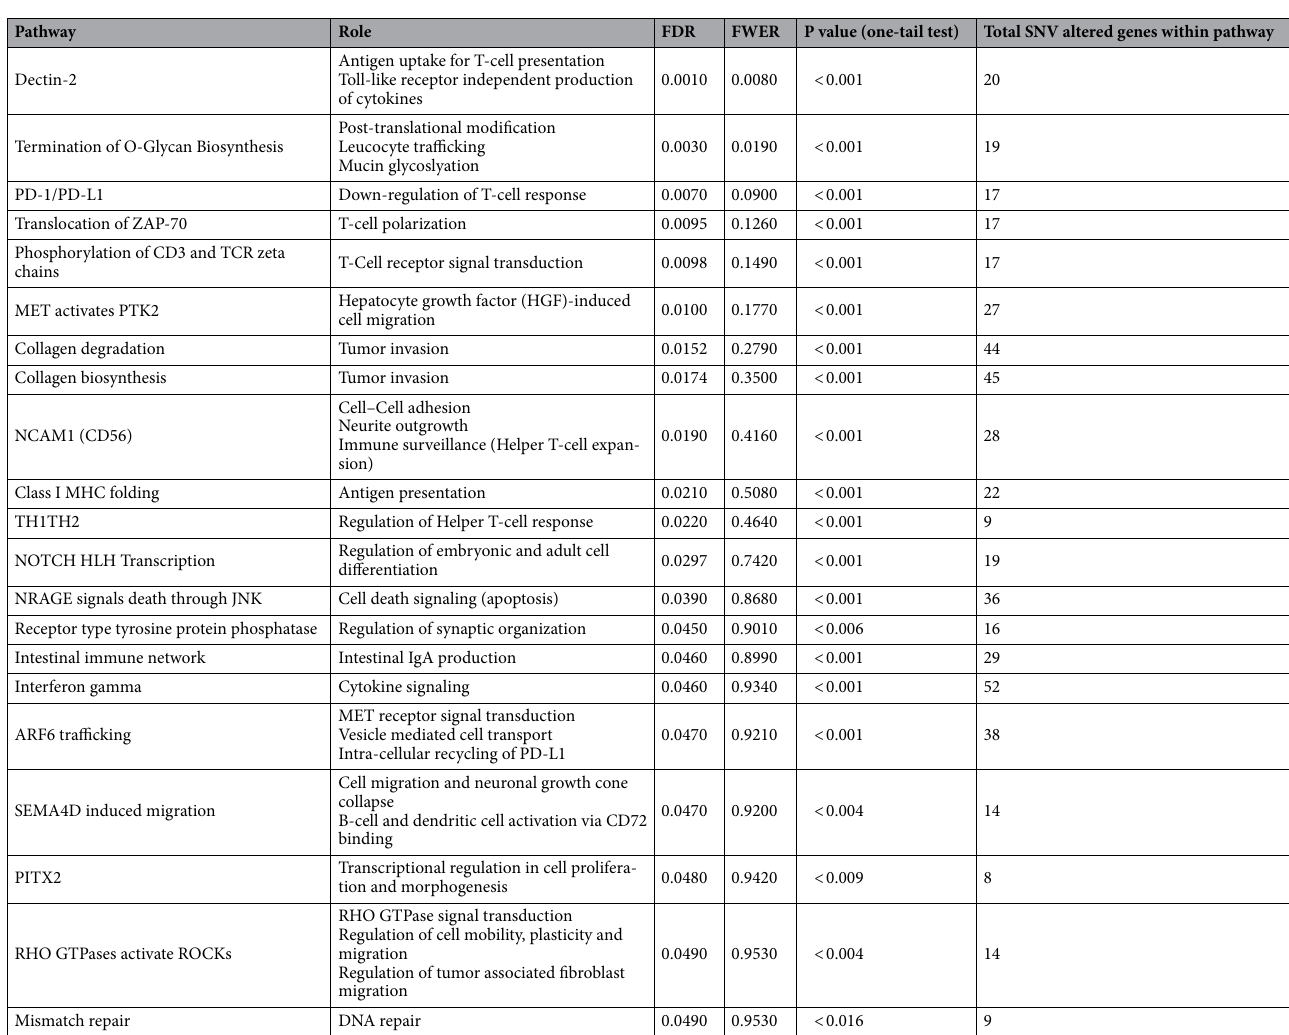
Table 3. Single nucleotide enriched cancer and immune response pathways. Table outlines significant single nucleotide variant enriched pathways (false discovery rate < 5%) identified from GSEA that pertain to cancer and immune biology. Pathways are listed in descending order of significance and highlight the propensity toward host immune pathways. A description of the biological role and number of genes containing altered single nucleotide variants is